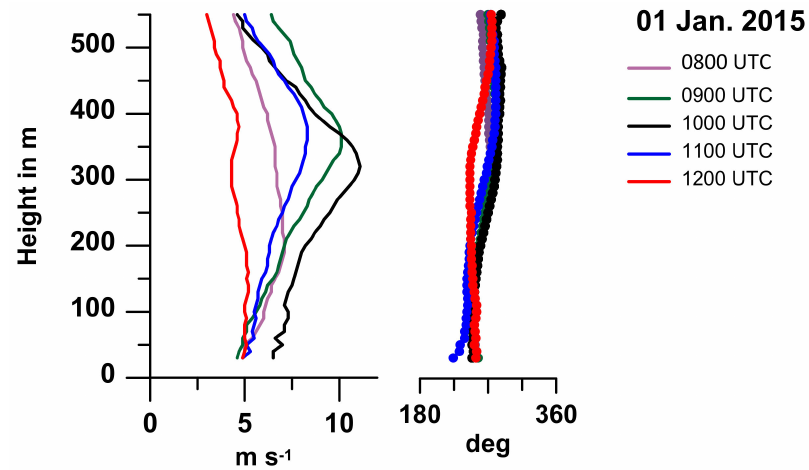
Figure 14. Vertical profiles from SODAR/RASS of the wind speed ( left ) and wind direction ( right ) for 1 January